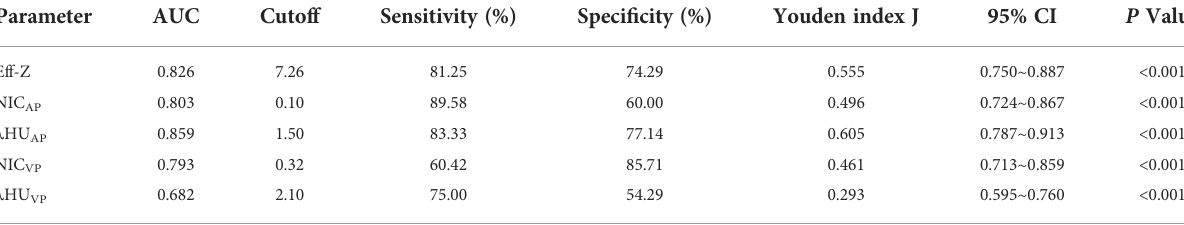
TABLE 4 Performance of DLCT parameters in differentiating advanced- from early-stage CRAC.